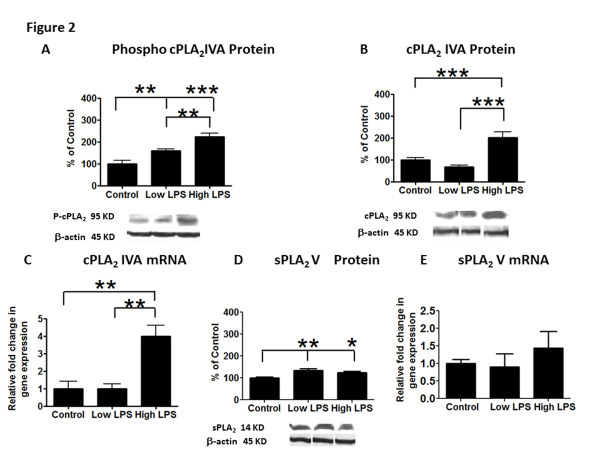
Mean (A) phosphorylated cPLA2-IVA, (B) cPLA2-IVA and (D) sPLA2-V protein levels (with representative immunoblots) in control, low- and high-dose LPS rat brain. Data are ratios of optical densities of protein to β-actin, expressed as percent of control and were compared using one-way ANOVA, mean ± SEM (n = 8). mRNA levels of (C) cPLA2-IVA and (E) sPLA2-V in control, low- and high-dose LPS in rat brain, measured using real time RT-PCR. Data are normalized to the endogenous control (β-globulin) and relative to control level (calibrator), using the ΔΔCT method. Comparisons between LPS groups were made using one-way ANOVA, mean ± SEM (n = 8), *p < 0.05, **p < 0.01.